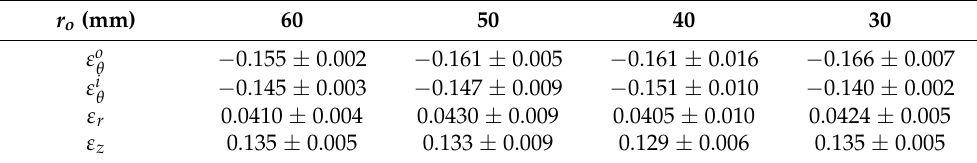
Table 2. Comparison of thermal strains with various annulus widths ( w ).